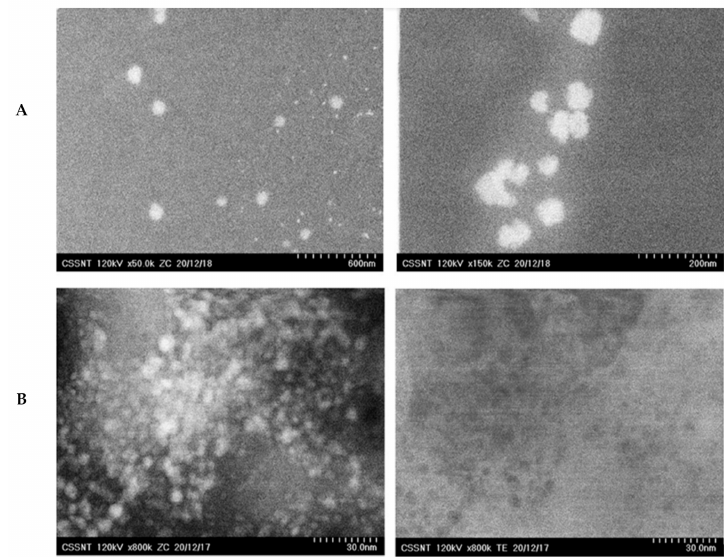
Figure 1. TEM images of NLC-DSG-Yam ( A ) Nanosphere diameter measurements. The diameters of the nanosphere were measured in ZC and TEM micrographs at different magnifications: × 50 K and × 150 K. ( B ) Co-localized measurements. Images obtained using different detectors (left, ZC—phase contrast and right—TE—transmission electrons), same area of the sample, at the same